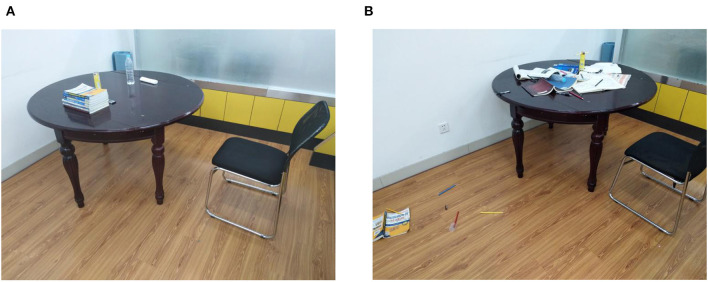
Illustration of the stimuli of Experiment 1: environmental order (A) and disorder (B) rooms.